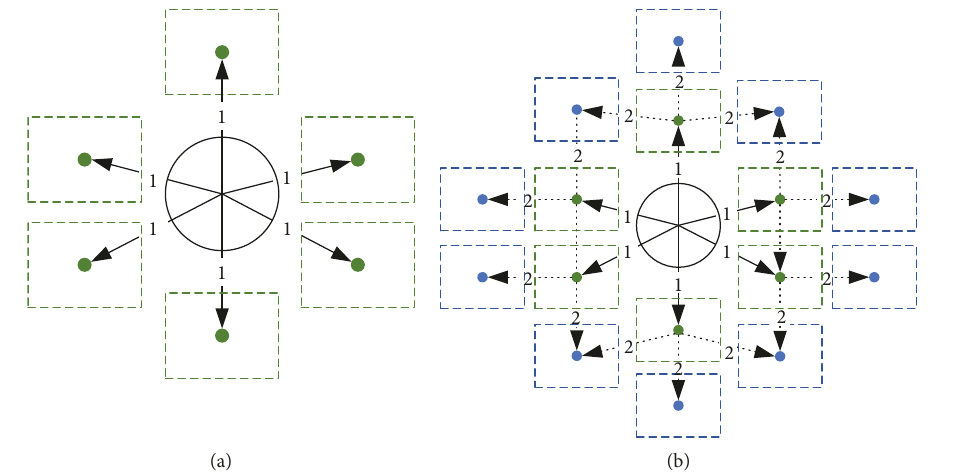
Figure 3: Illustration of population initialization method. (a) First search. (b) Second